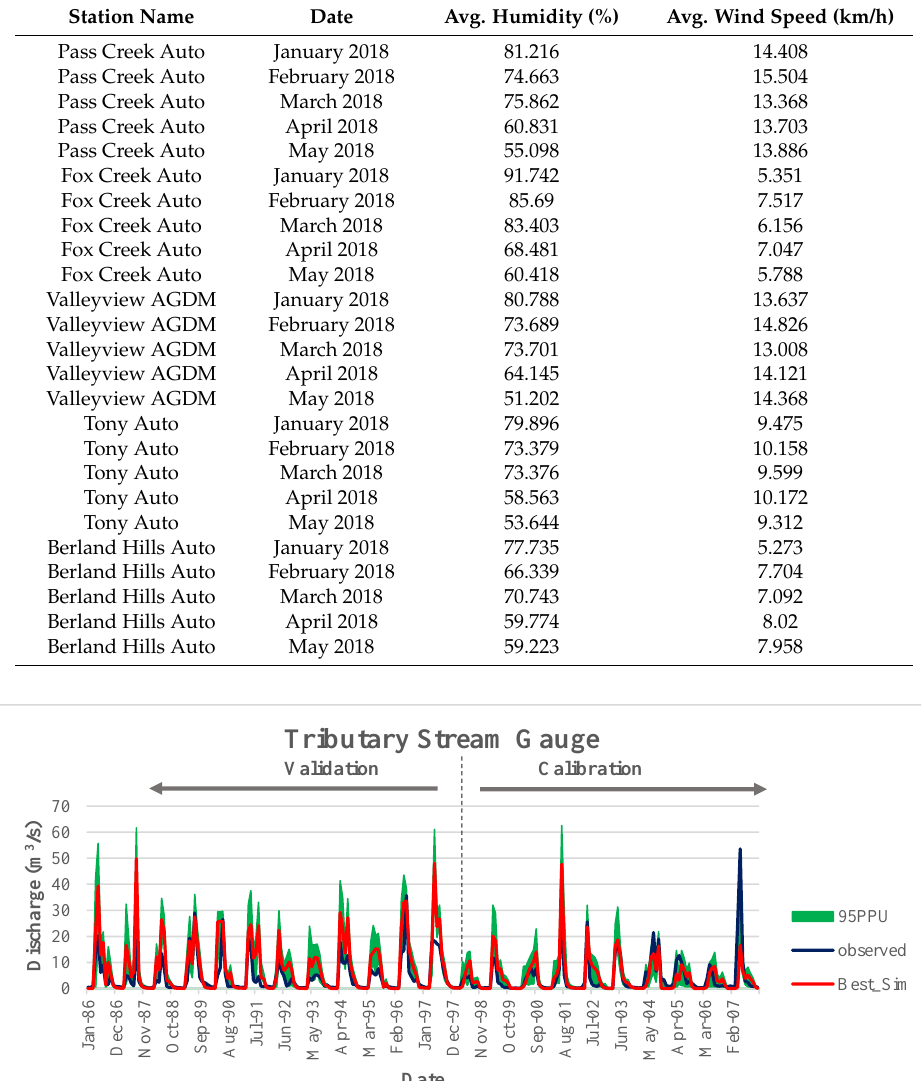
Insert the spreadsheet into the middle of the MODFLOW VMP file. Table A3. Weather gauges near the Little Smoky River watershed, with example average humidity and wind speed data for 2018 (modified from Alberta Agriculture and Forestry, 2018).